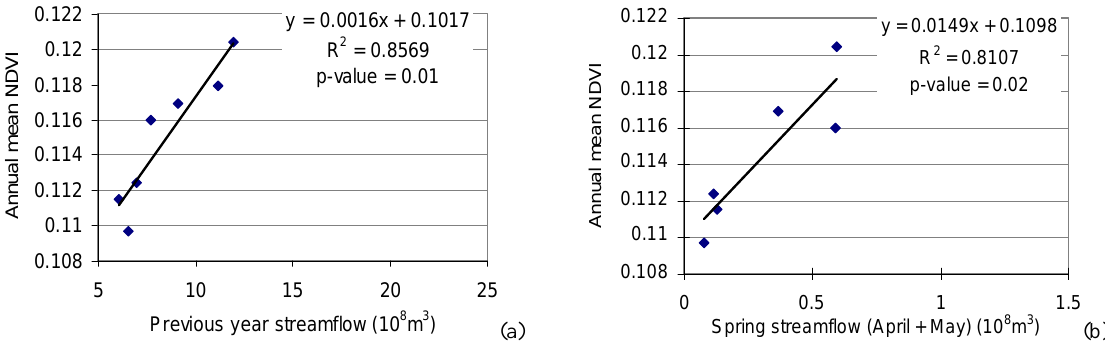
Fig. 9. (a) Area-averaged annual mean NDVI of year N versus total river streamflow of year ( N − 1); (b) area-averaged annual mean NDVI of year N versus total river streamflow of March through May of year N.